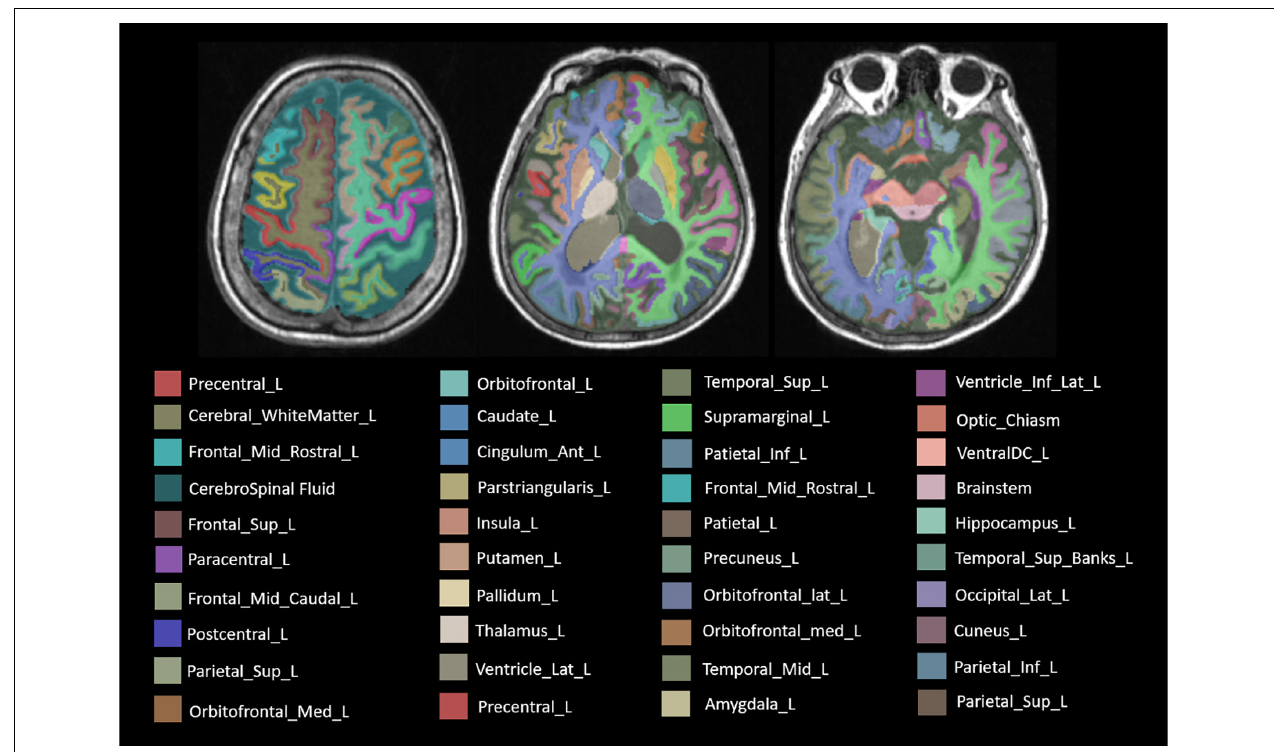
FIGURE 3 | The label of main brain regions in structural MRI (sMRI) after automatic segmentation. Specially, the symmetrical structure is divided into left and right and has different labels. Only the structure on the left is marked above.